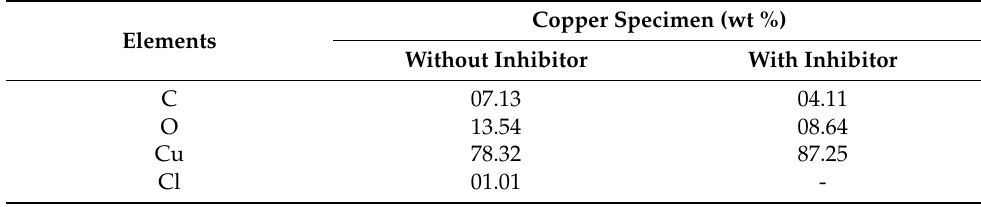
Table 5. Surface composition of copper before and after immersion in 1 M HCl, with and without 1000 ppm